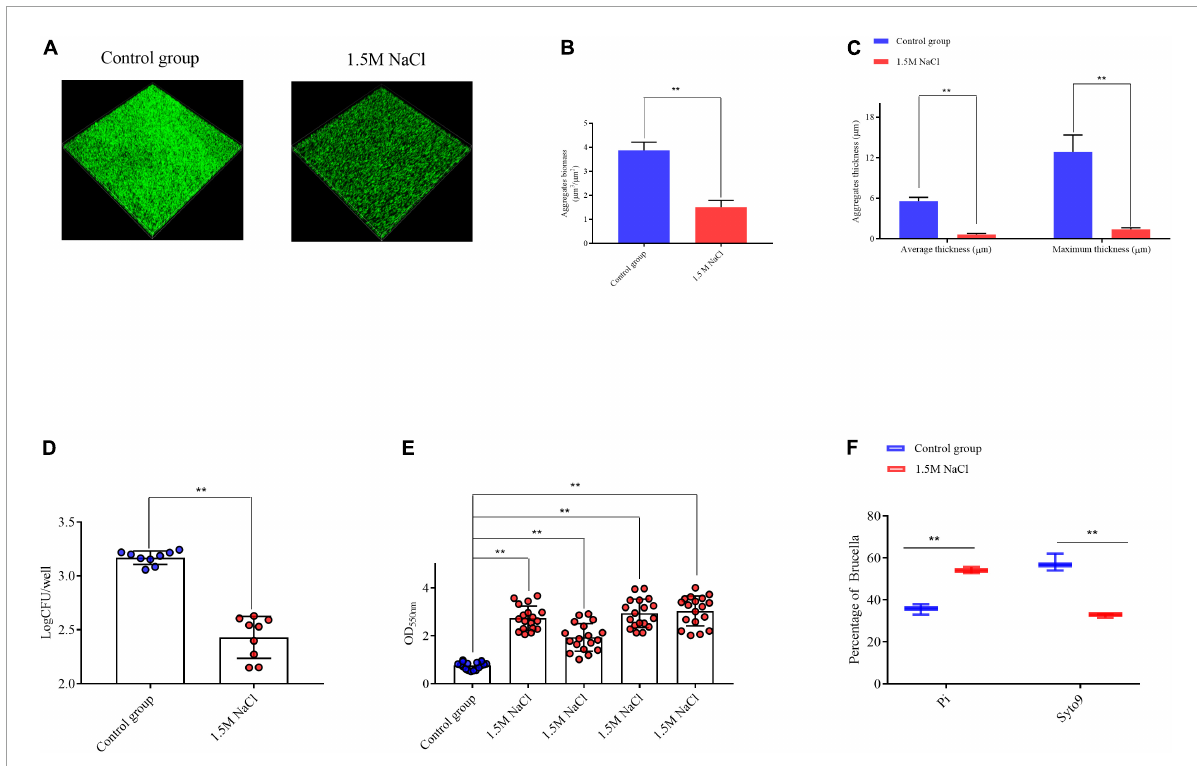
FIGURE1 Analysis of B. melitensis 16M aggregation ability in 1.5 M NaCl and control conditions. (A) Live confocal imaging of stacks of B. melitensis 16M-GFP aggregates grown for 72 h in Brucella broth medium with or without 1.5 M NaCl. Scale bars = 20 µ m. Confocal images were subjected to quantitative analysis using the Comstat2 program to determine the aggregates biomass (B) and the average and maximum aggregates thickness (C) . (D) Survival of bacteria in aggregates grown with or without 1.5 M NaCl treatment. (E) The biomass of aggregates was quantified with 0.1% CV. (F) Flow cytometry analysis of the live/dead status of bacteria in the biofilm filtrates. Error bars represent standard error ( n ≥ 3). ** P ≤ 0.01, unpaired Student’s t